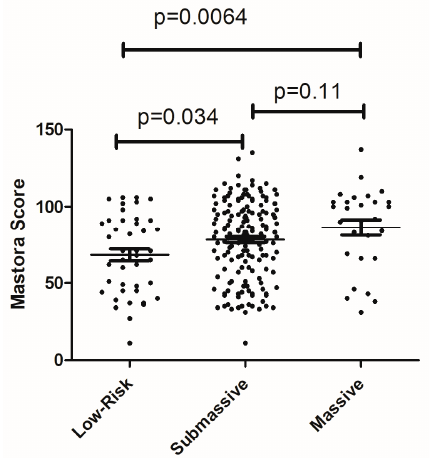
Figure 3. Comparison of Mastora score values between patients with low risk pulmonary embolism (PE), submassive and massive PE.